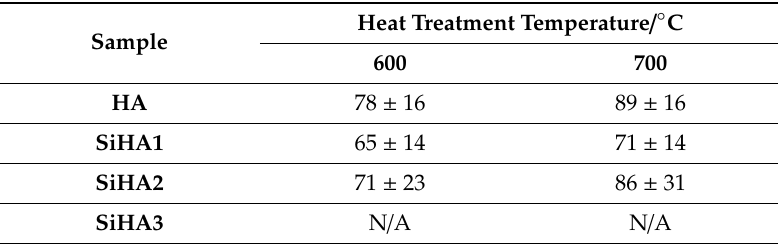
Table 2. A summary of HA crystallite size (nm) calculated by the Scherrer equation for HA and SiHA thin films sputtered onto silicon (100) single crystal wafer using the < 001 >